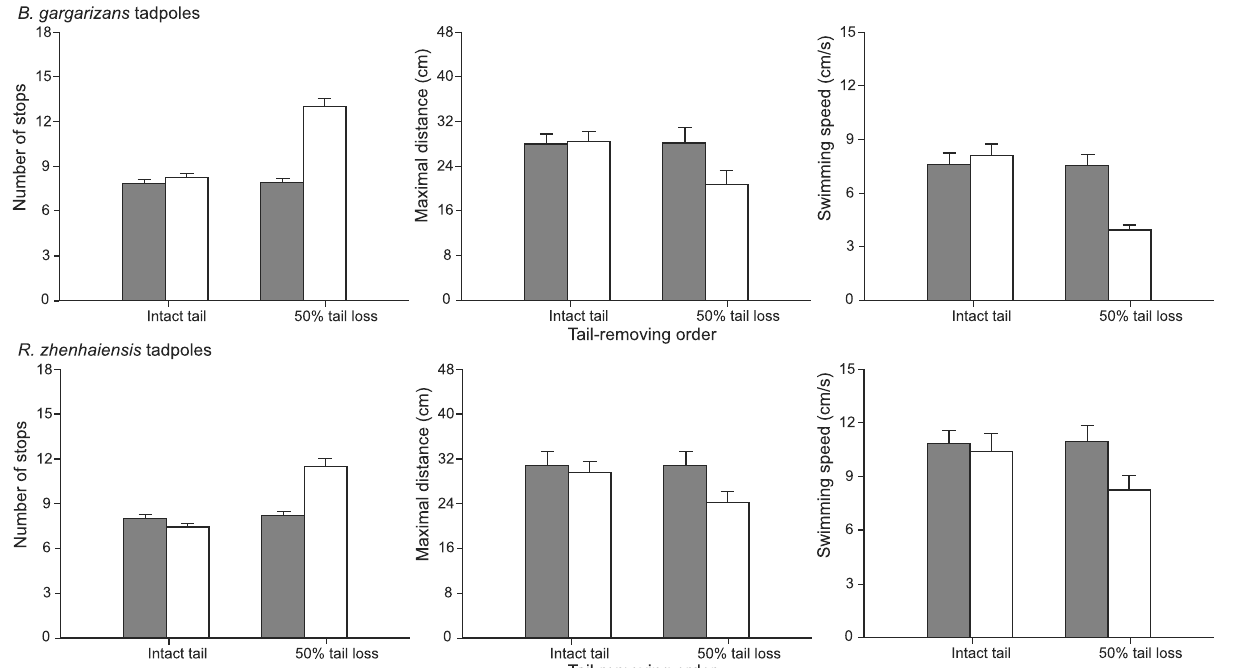
Figure 3. Mean values (+SE) for swimming performance (number of stops, maximal distance and swimming speed) in the two species before and after 50% tail loss. Black bars: C tadpoles; open bars: E